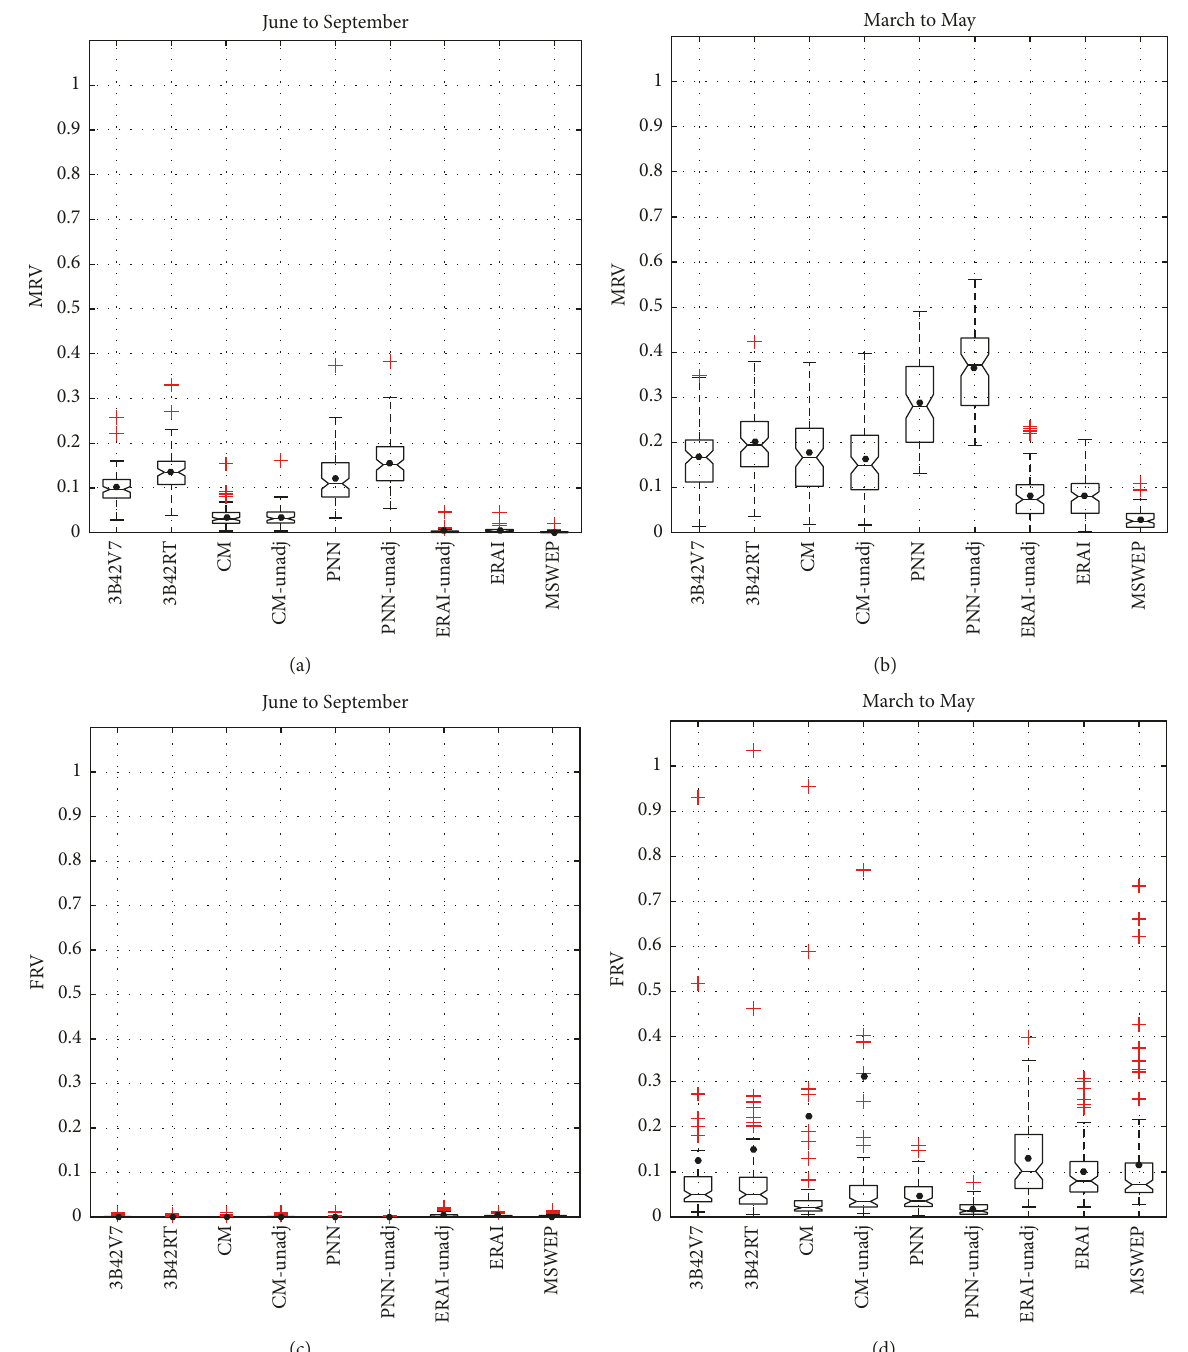
Figure 5: MRV and FRV for June to September (a and c) and March to May (b and d).